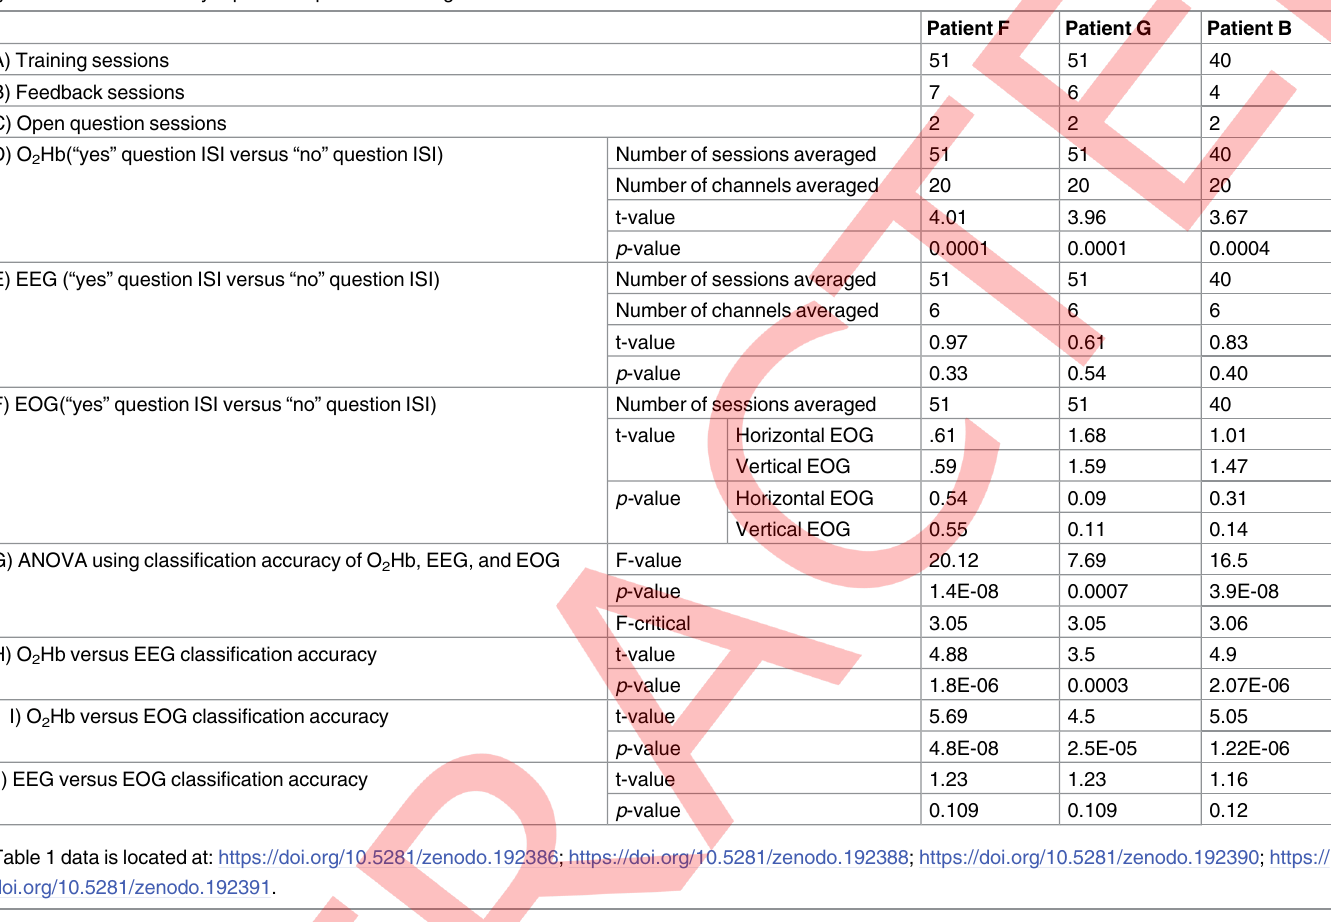
Table 1 data is located at: https://doi.org/10.5281/zenodo.192386; https://doi.org/10.5281/zenodo.192388; https://doi.org/10.5281/zenodo.192390; https:// doi.org/10.5281/zenodo.192391.